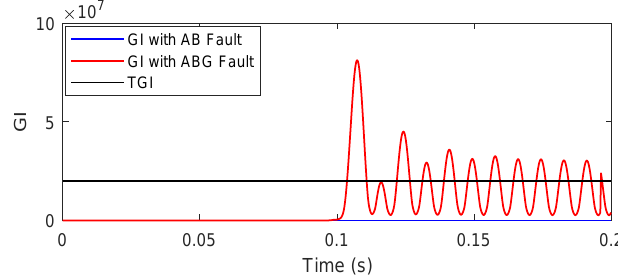
Figure 9. Index for ground fault classifying AB and ABG faults.